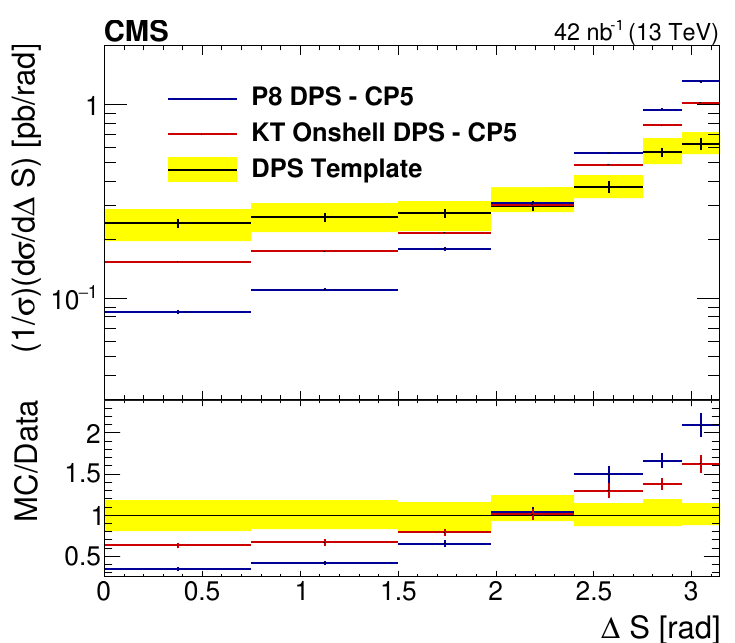
Figure 13 . The ∆ S distribution obtained from the mixed data sample compared to predictions from the pure DPS sample in pythia 8 (P8) and KaTie (KT). The distributions are normalized to unity. The error bars represent the statistical uncertainty, and the yellow band indicates the total (statistical+systematic) uncertainty on the